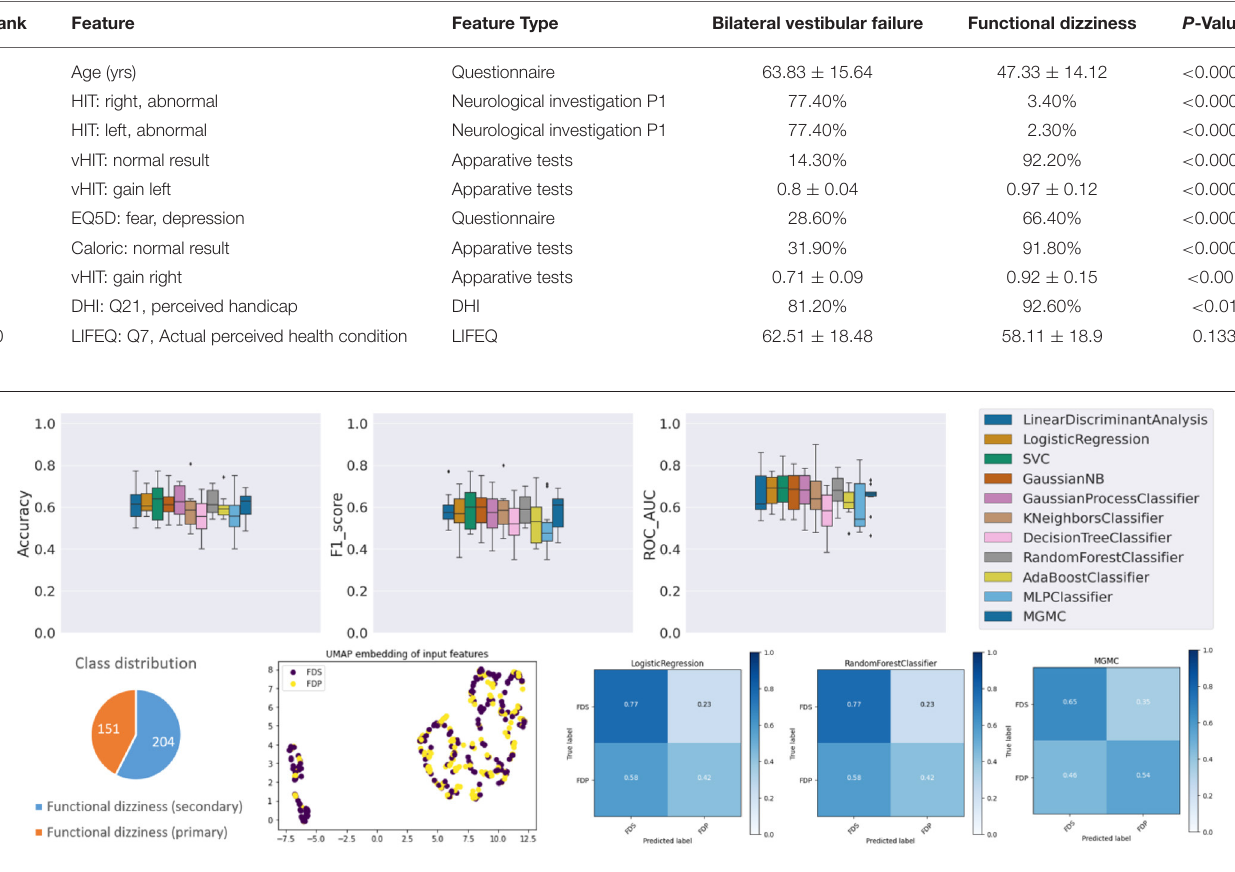
FIGURE 3 | Results panel produced by base-ml for Task 2. TABLE 3 | Top 10 most important features in Task 2, aggregated over multiple